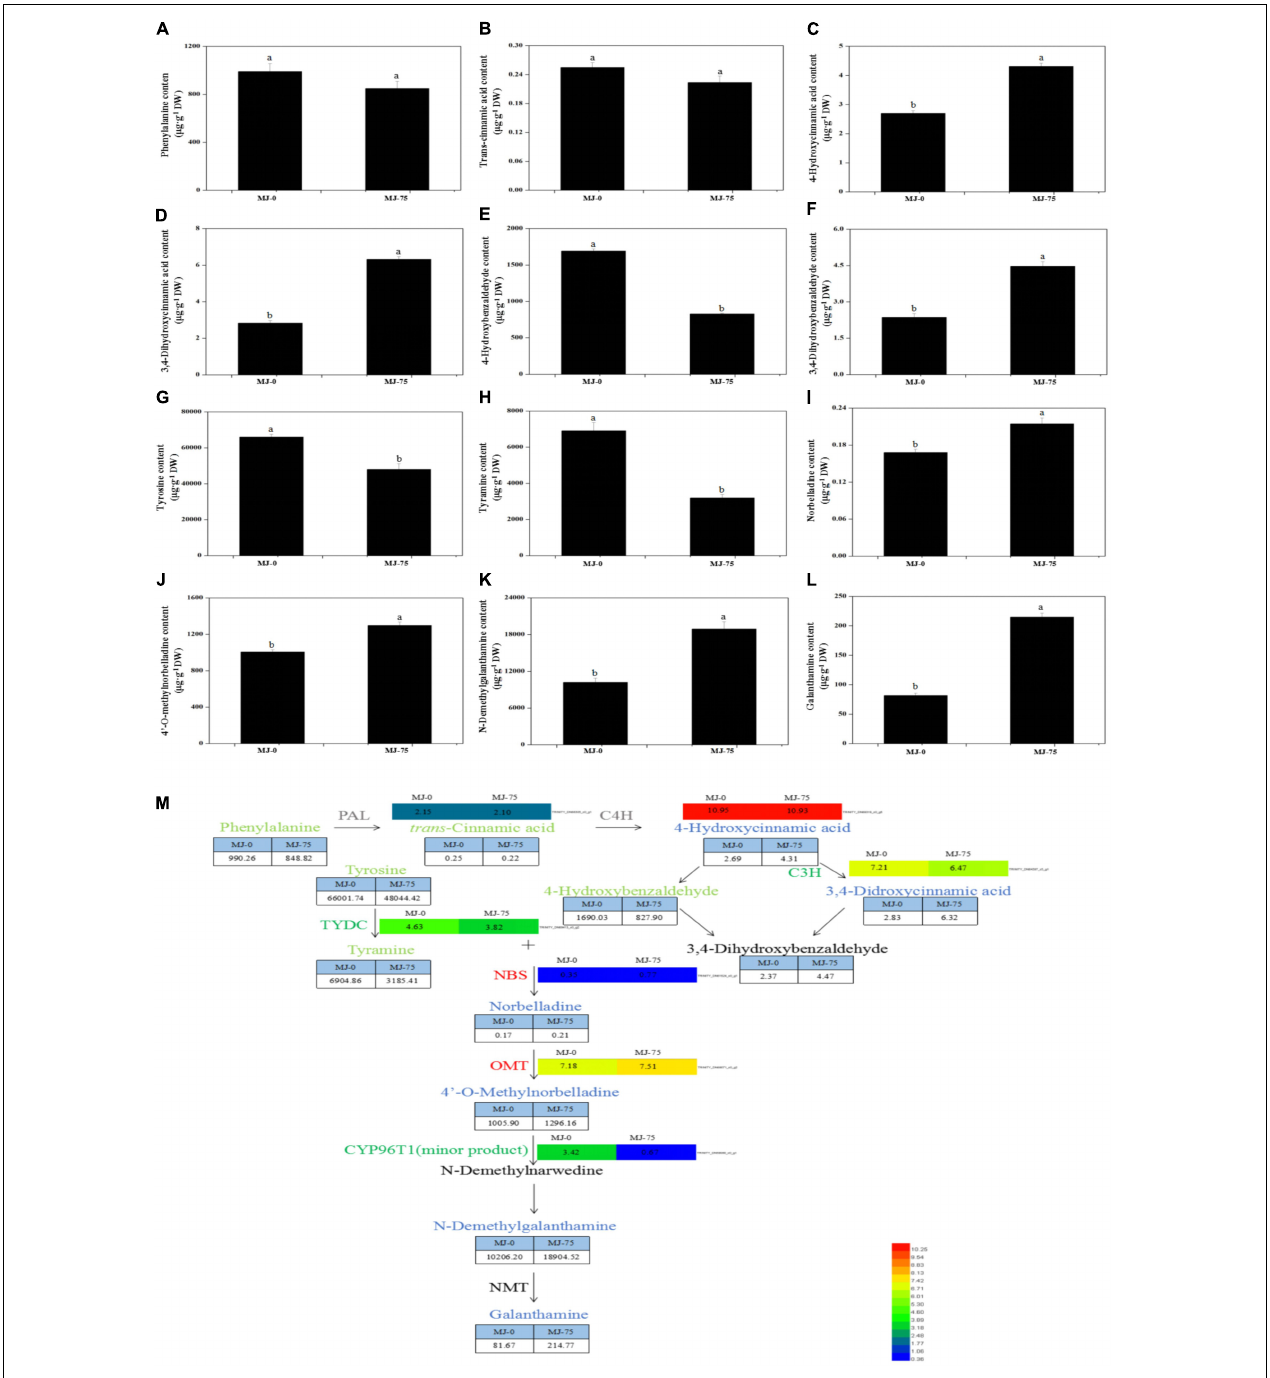
FIGURE 6 | Proposed Gal biosynthesis pathway analysis in the different MJ treated L. longituba seedlings. Phenylalanine (A) , trans-cinnamic acid (B) , 4-hydroxycinnamic acid (C) , 3,4-dihydroxycinnamic acid (D) , 4-hydroxybenzaldehyde (E) , 3,4-dihydroxybenzaldehyde (F) , tyrosine (G) , tyramine (H) , norbelladine (I) , 4 (cid:48) -O-methylnorbelladine (J) , N-demethylgalanthamine (K) , and galanthamine (L) contents as measured by LC-MS/MS. Error values indicate the standard deviation (SD). Least-significant difference test (LSD, p < 0.05) was used to compare the means. Different letters represent significant differences between groups ( N = 3, p < 0.05). (M) Proposed Gal biosynthesis pathway in L. longituba . Red or blue colors represent up-regulated genes or metabolites, green colors indicate down-regulated genes or metabolites, black colors represent non-detected metabolites or genes, and gray colors are genes or metabolites that did not change significantly under MJ-75 treatment. Heat maps showed the normalized gene expression values which represent the means ± SD of three biological replicates. Metabolites contents showed the means ± SD by LC-MS/MS. Gene expression values are presented as FPKM normalized log2-transformed counts ( N = 3, p <